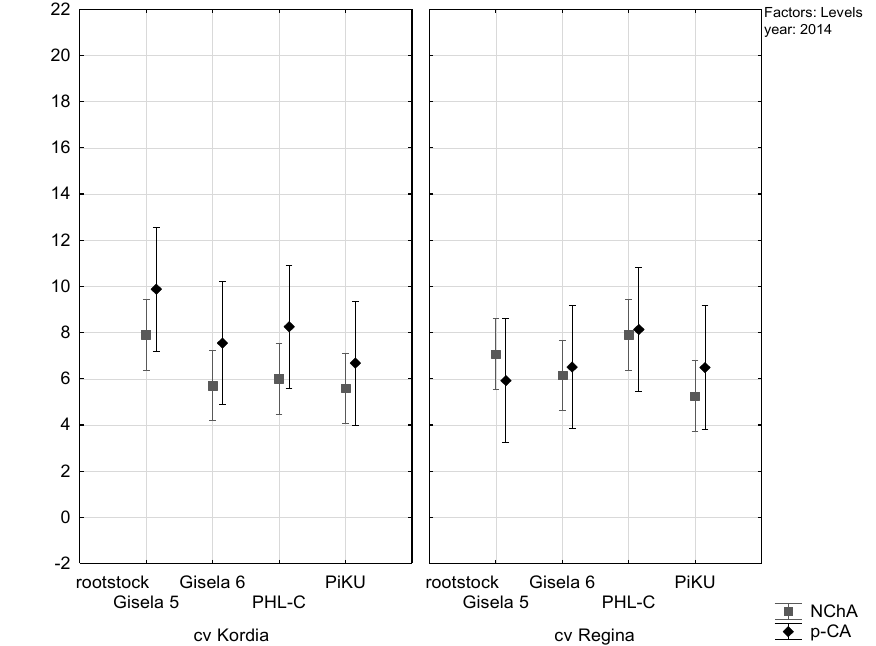
Fig. 3: p-Coumaric acid (p-CA) and neochlorogenic acid (NChA) (mg/100 g FW) of cvs. ‘Kordia’ and ‘Regina’ grafted on 4 different rootstocks during